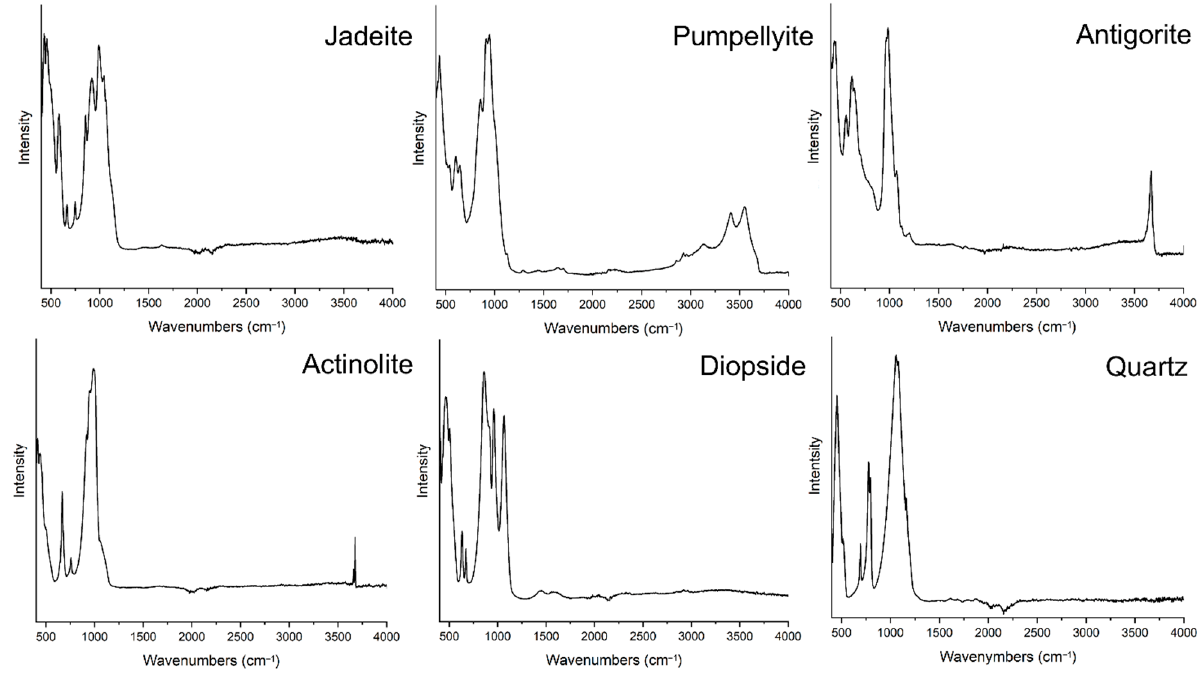
Figure 8. Reference IR absorption spectra of several Green Stones samples, re-plotted from RRUFF: Jadeite N. R050220-1 [143], Actinolite N. R040063-1 [144], Pumpellyite N. R070130-1 [153], Diopside N. R040009-1 [152], Antigorite N. R070228-1 [147], and Quartz N. R040031-1 [154]. Powder samples